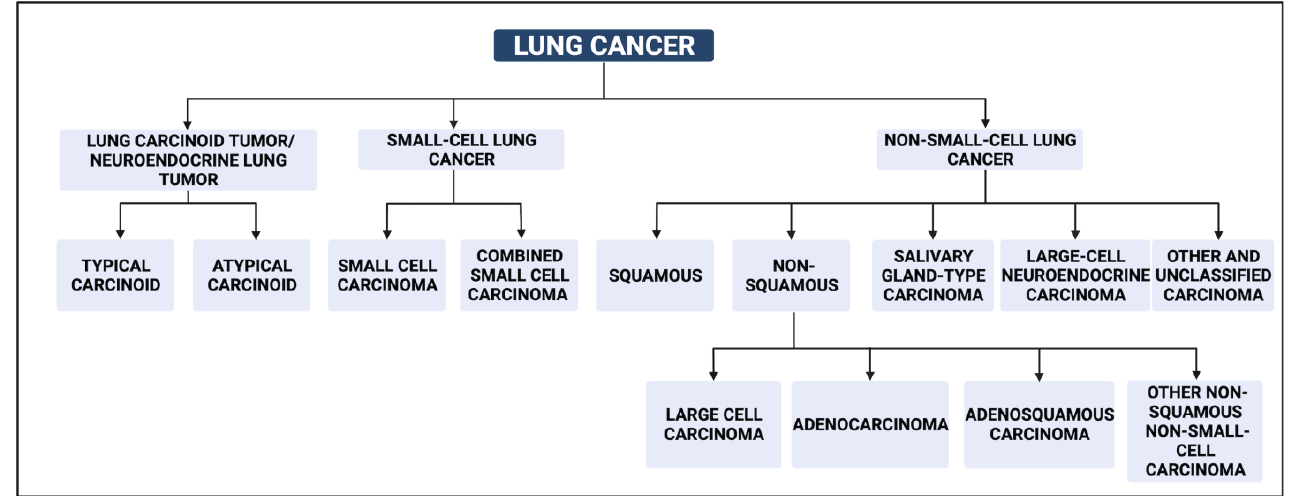
Figure 1. WHO 2015 classification of LC.